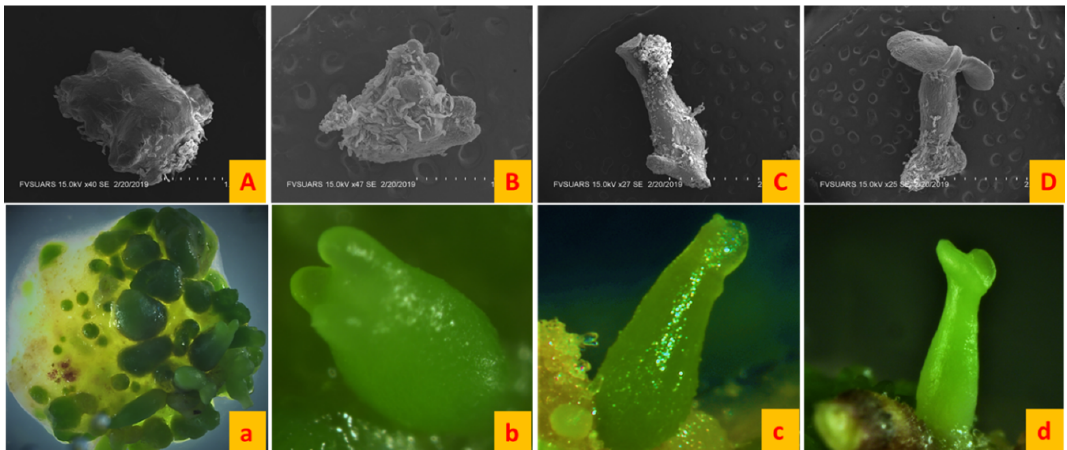
Figure 3. Different stages of somatic embryogenesis as seen under the light microscope ( a – d ) and scanning electron microscope ( A – D ). ( A and a ) Globular shaped, ( B and b ) heart shaped, ( C and c ) torpedo shaped and ( D and d ) cotyledonary staged. For all SEM images ( A – B ) bar = 1.00 mm, ( C – D ) bar = 2.00 mm and all light microscope images at 12× magnification. All stages were taken from the SH4K-BOi2Y system.